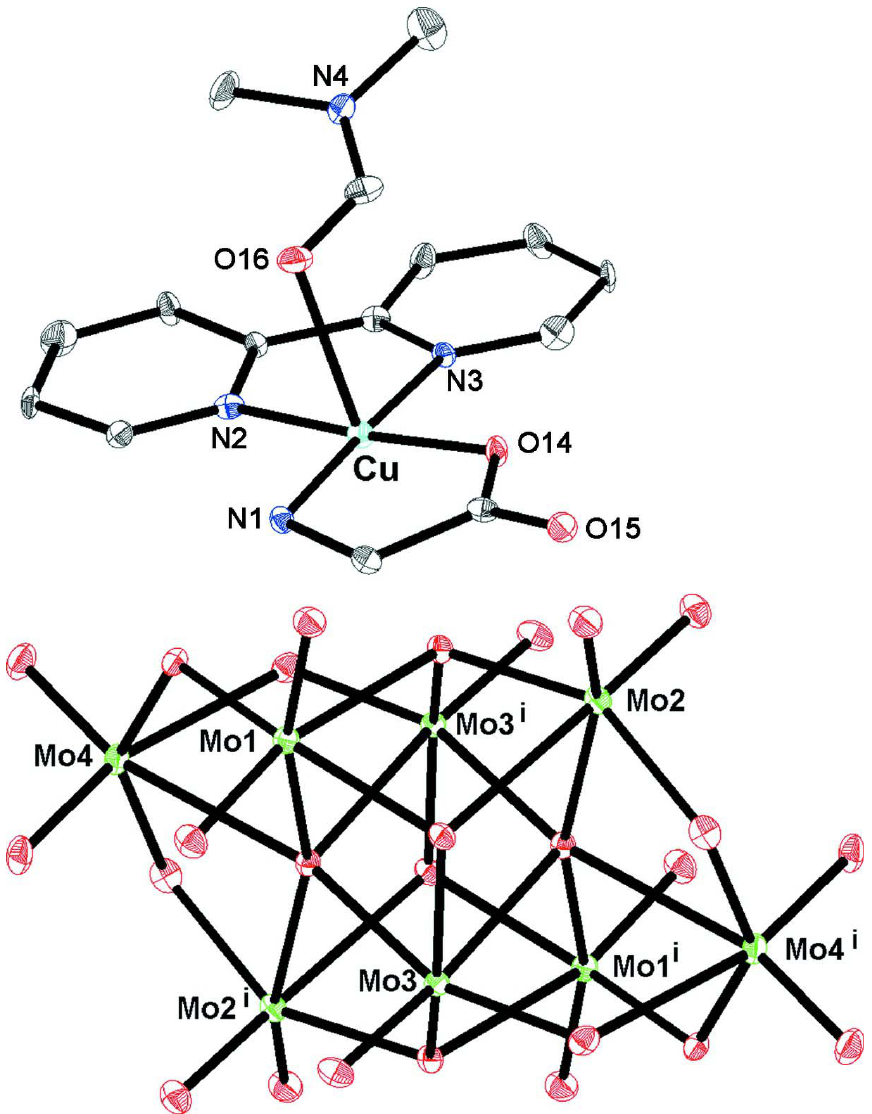
The structures of the anion and cation of the title compound (the ammonium ion has been omitted). Displacement ellipsoides are drawn at the 30% probability level. [Symmetry code: (i) 1 - x , 1 - y , 1 - z